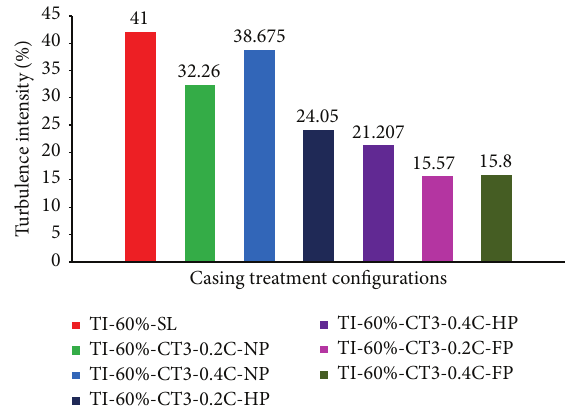
Figure 17: Comparative variations of turbulence intensity for the solid casing and casing treatment configuration at 60% operating speed at stall flow (SF) condition for 20% and 40% axial